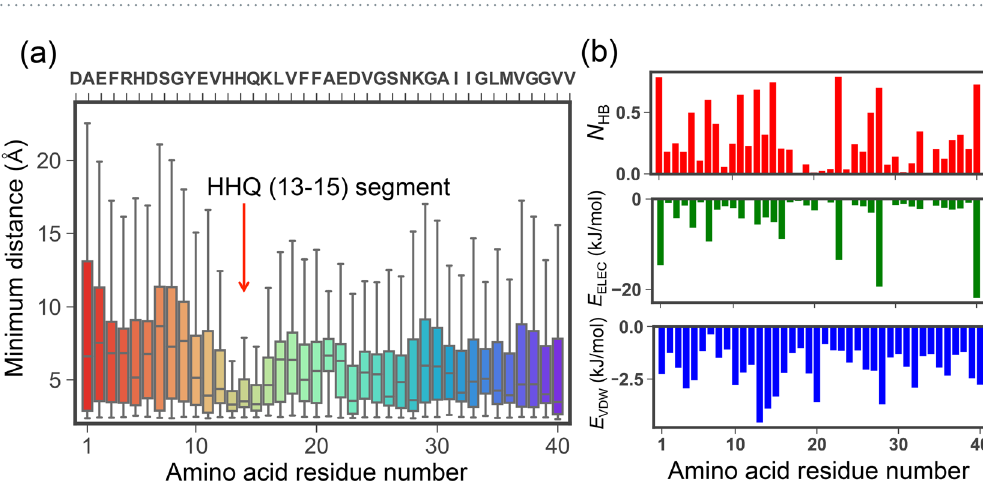
Figure 3. ( a ) Boxplots of minimum distance between each amino acid residue of A β 40 and the GM1-glycan cluster. ( b ) The average values of the number of hydrogen bonds N HB (upper figure), electrostatic interaction energy E ELEC (middle figure), and van der Waals (VDW) interaction energy E VDW (lower figure) between each amino acid residue and the GM1-glycan